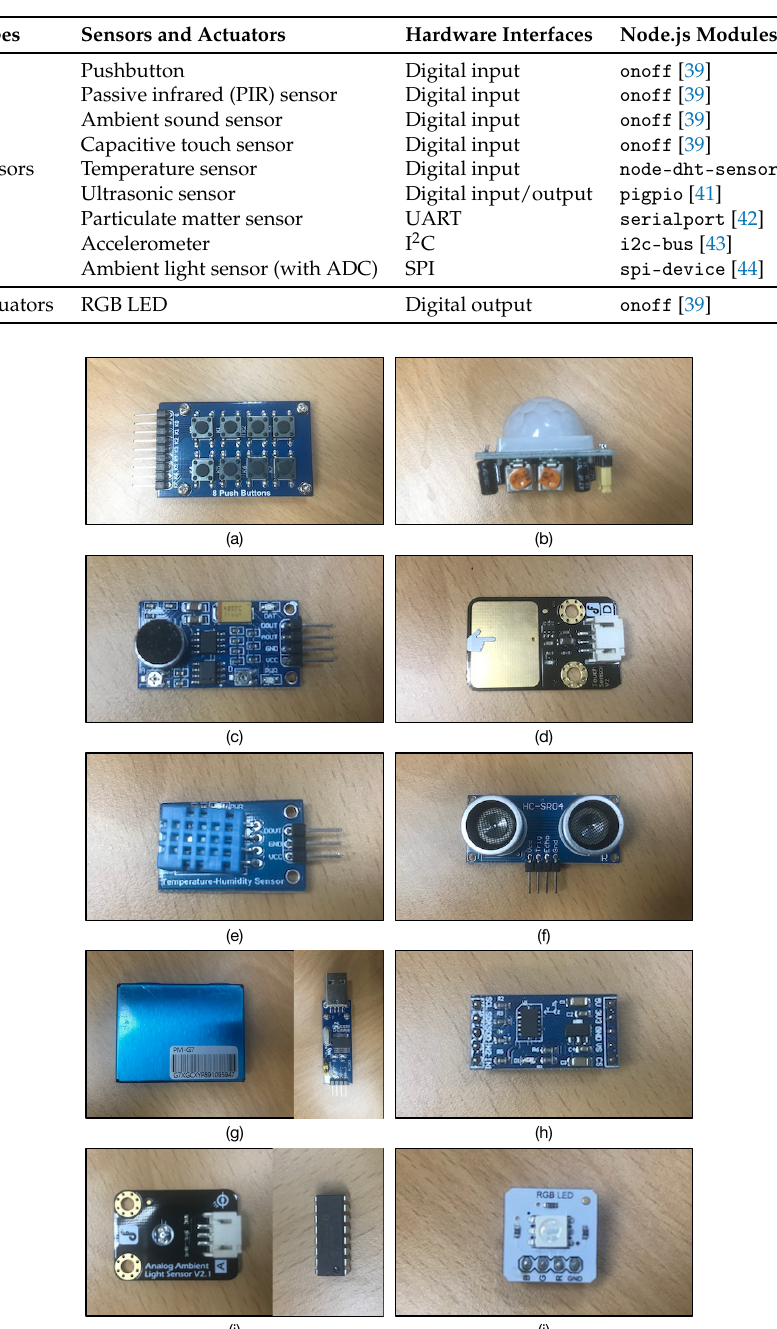
Table 3. The sensors and actuators chosen for our implementation work and corresponding Node.js package deployed.